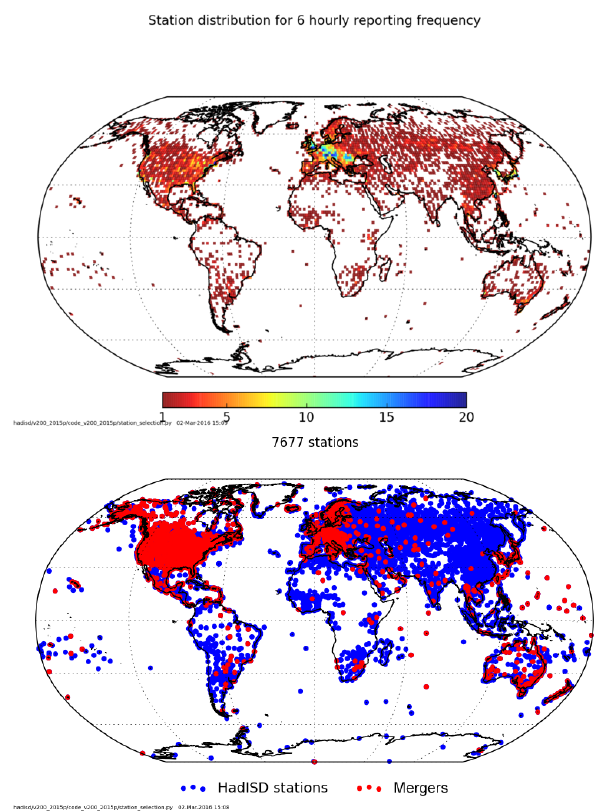
Figure 3. Top panel: the location of the final set of stations. For pre- sentational purposes we show the number of stations within 1 ◦ × 1 ◦ grid boxes. Bottom panel: the locations of the 1993 stations which are composites (red) with all non-composites shown in blue. The composite stations are plotted on top of the non-composites and so dominate the area in locations with high station densities, e.g. North America and